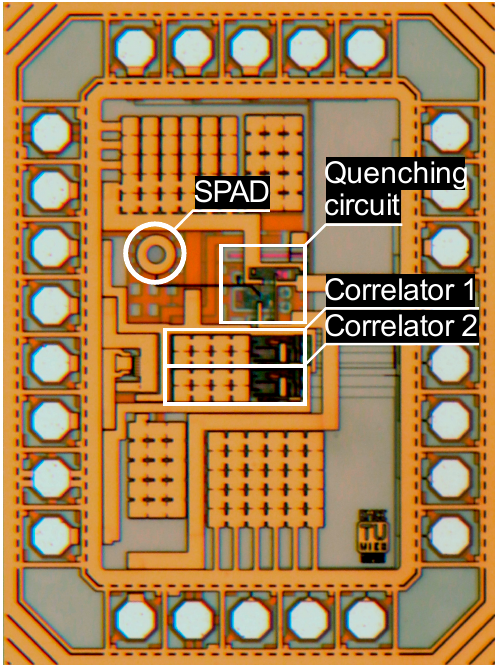
Figure 4. Photomicrograph of the fabricated prototype, with marked SPAD, quenching circuit, and correlators.